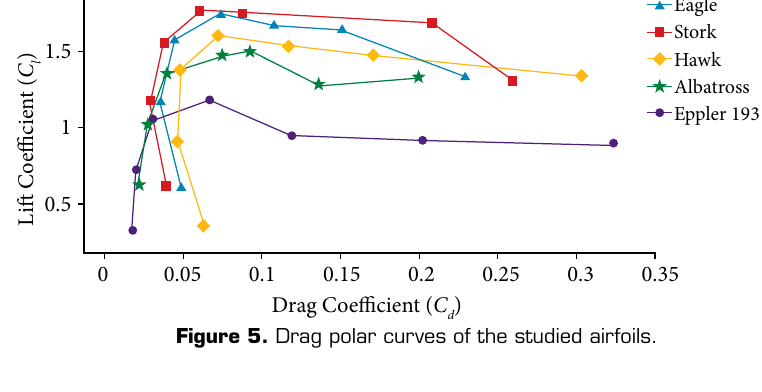
Figure 5. Drag polar curves of the studied airfoils.